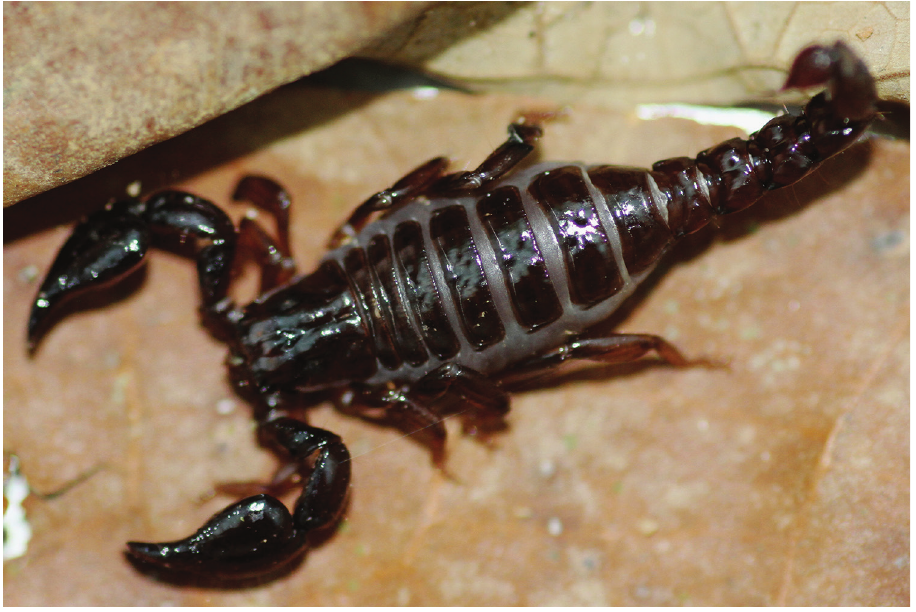
Figure 20. Auyantepuia laurae , female holotype from Saut Sabbat.